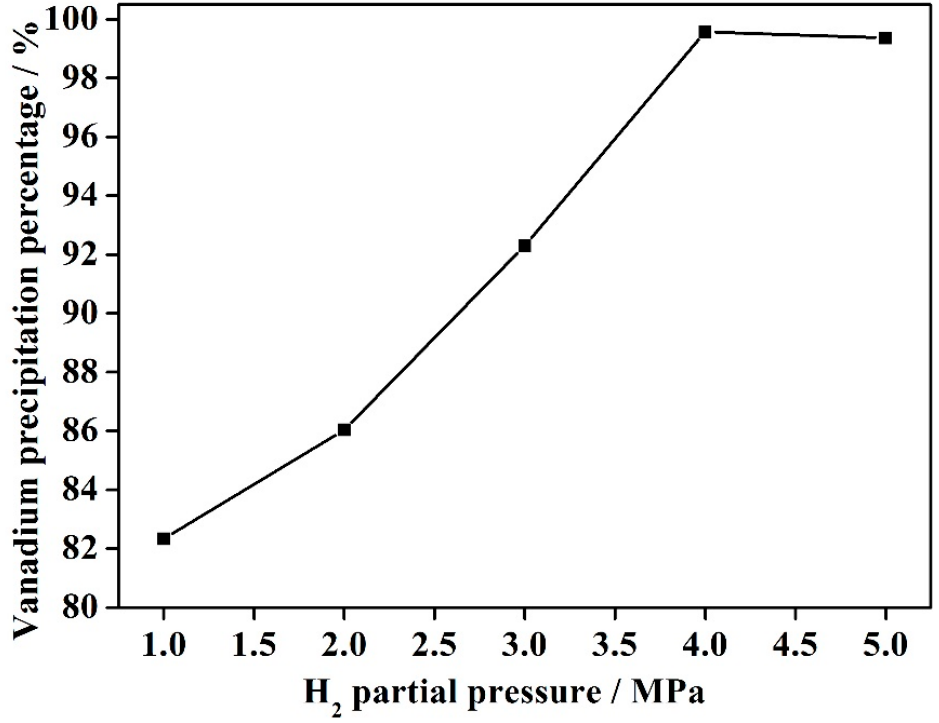
Figure 7. The e ff ect of H 2 gas partial pressure on vanadium precipitation Figure 7. The effect of H 2 gas partial pressure on vanadium precipitation percentage.